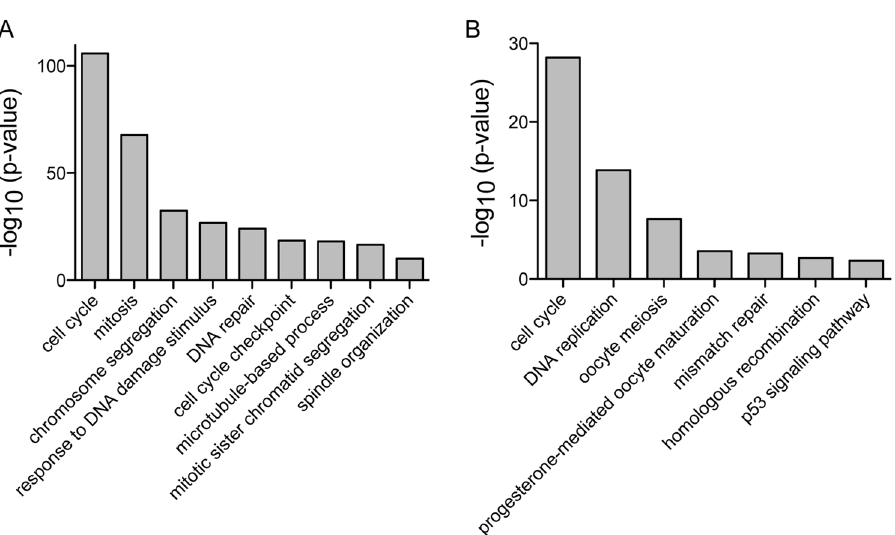
Figure 4. Genes transcriptionally co-expressed with DTL in LuADCs are significantly enriched for cell cycle and DNA repair pathways by Gene Ontology ( A ) and KEGG pathway ( B )